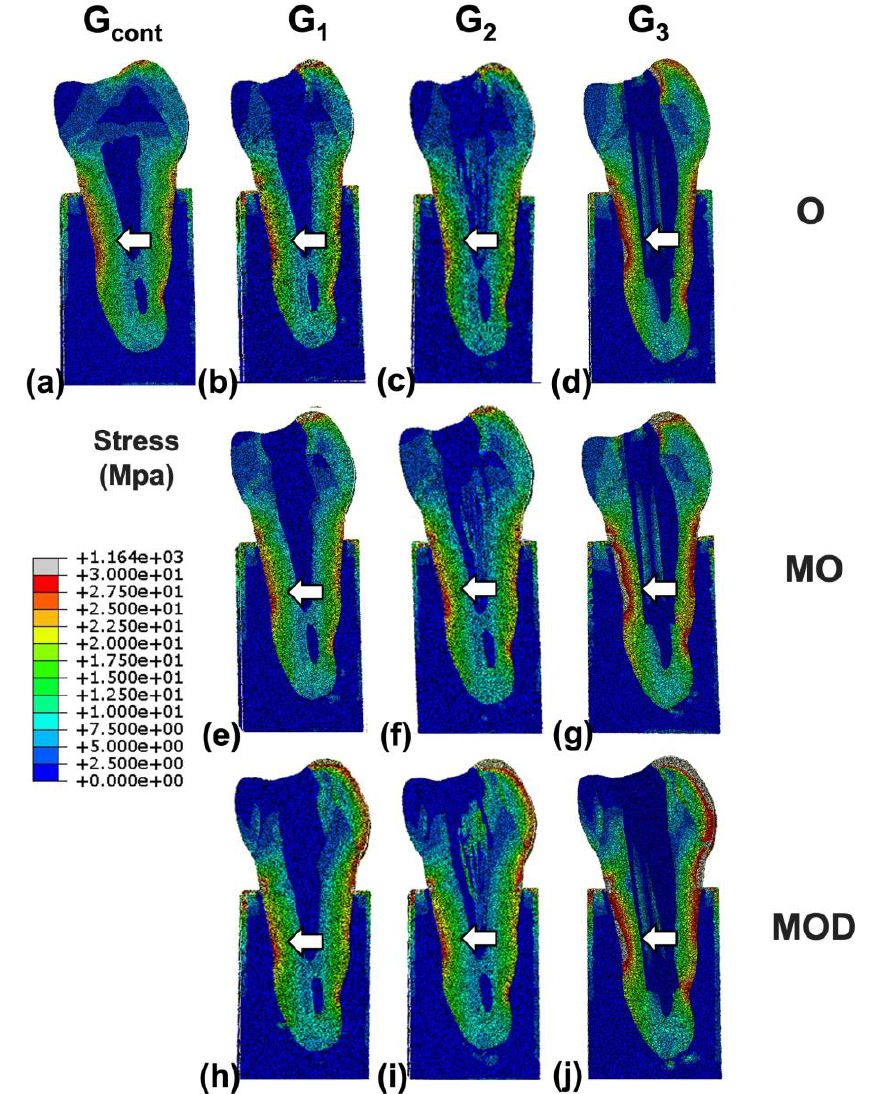
Figure 6. Stress distributions for finite element models representative of ( a ) intact, ( b ) occlusal (O) resin, ( c ) O multiple fiber-reinforced composite (mFRC), ( d ) O single fiber-reinforced composite (sFRC), ( e ) mesio-occlusal (MO) resin, ( f ) MO mFRC, ( g ) MO sFRC, ( h ) mesio-occluso-distal (MOD) resin reconstructions, ( i ) MOD mFRC and ( j ) MOD sFRC. A single post is present in the center of the root canal where stresses are low (white arrows are presenting different stress concentrations in the root depending on the restorative choice).